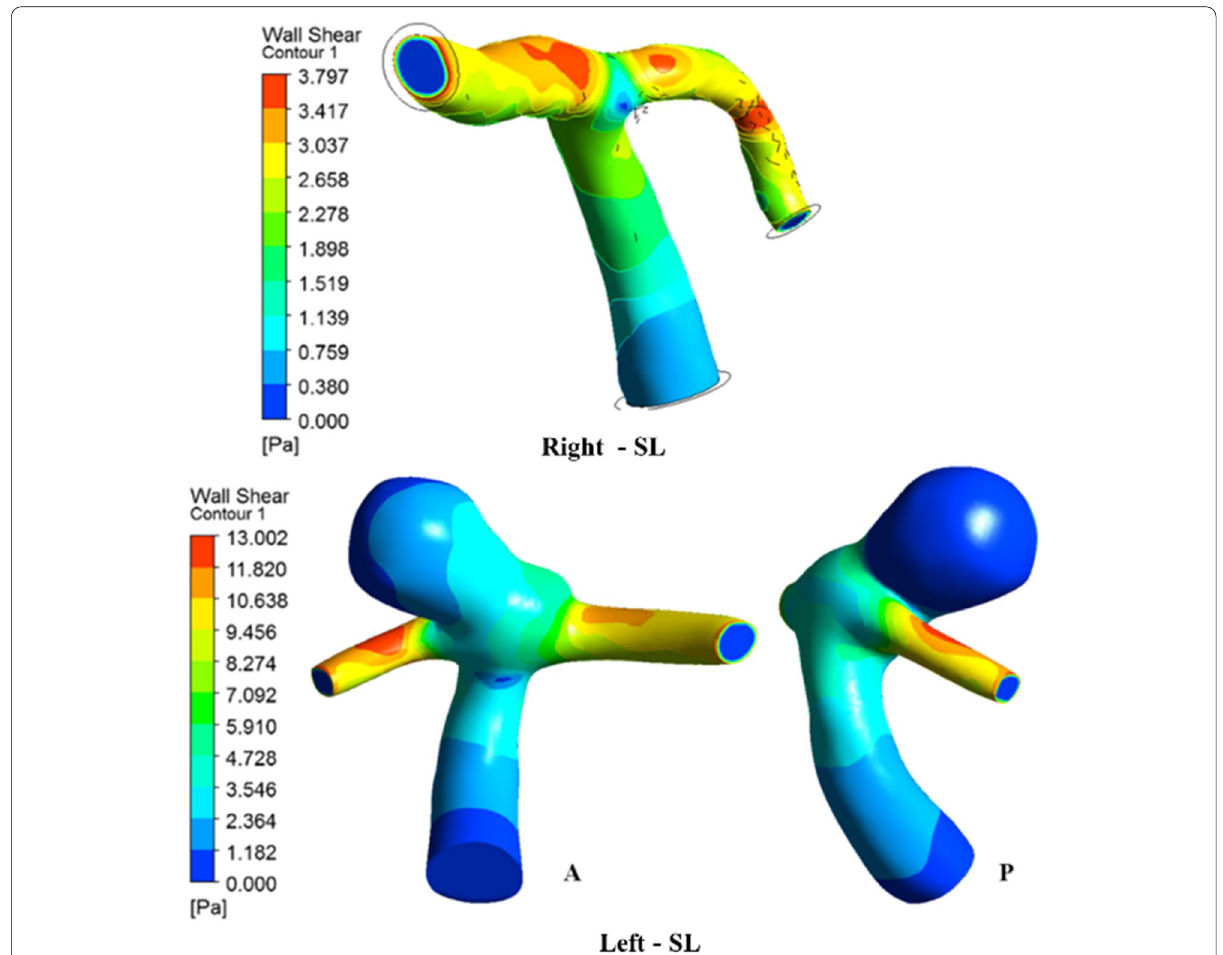
Fig. 8 Comparison of WSS contours during peak